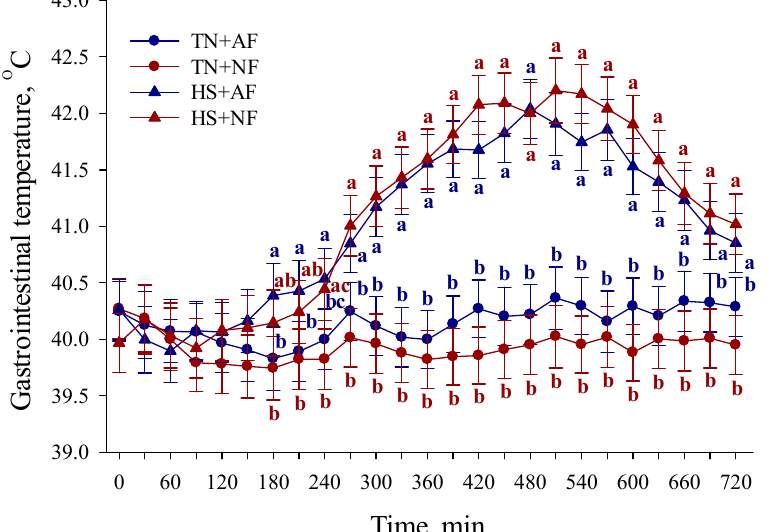
Figure 2. Effects of feed removal on gastrointestinal temperature recorded every 30 min in finishing pigs during the first 12 h of temperature and feeding treatment period. TN: thermoneutral; HS: heat stress; AF: access to feed; NF: no access to feed. Error bars indicate ± 1 SEM. Letters a, b, and c indicate differences at each 30 min time point ( p < 0.01).